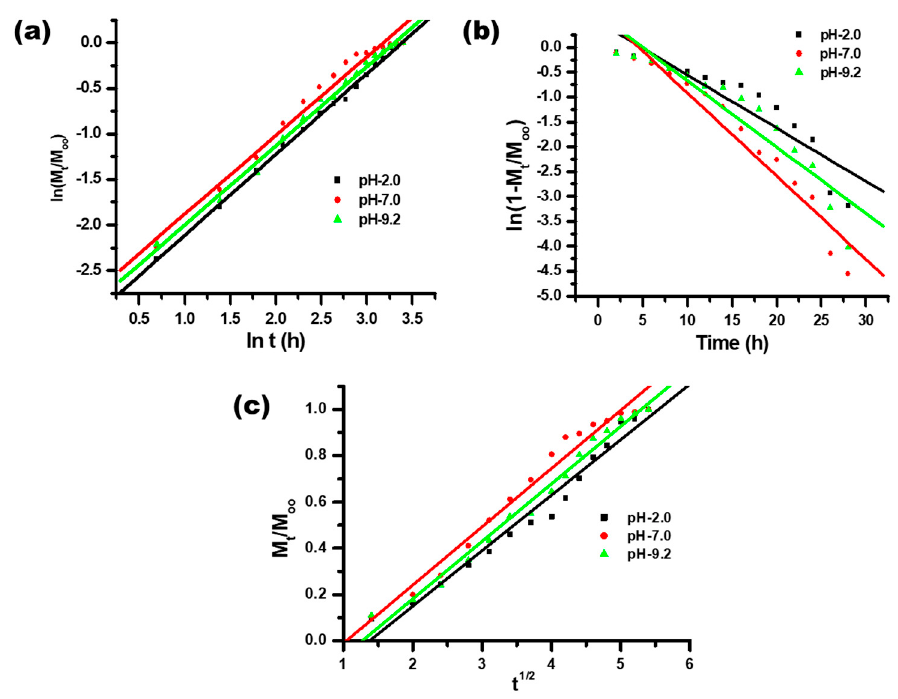
Figure 8. Plot of ( a ) ln (M t / M ∞ ) vs . ln t; ( b ) ln(1- M t / M ∞ ) vs. time and ( c ) M t / M ∞ vs. t 1/2 for the release of itraconazole from synthesized CH-Ag bionanocomposite.